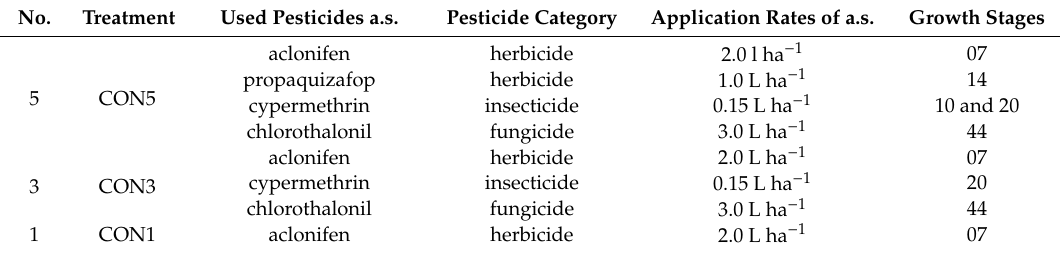
Table 1. Used synthetic pesticides in treatments, classification by target organisms, and growth stages of carrot [36] when spraying was carried out in the conventional cultivation from 2011 to